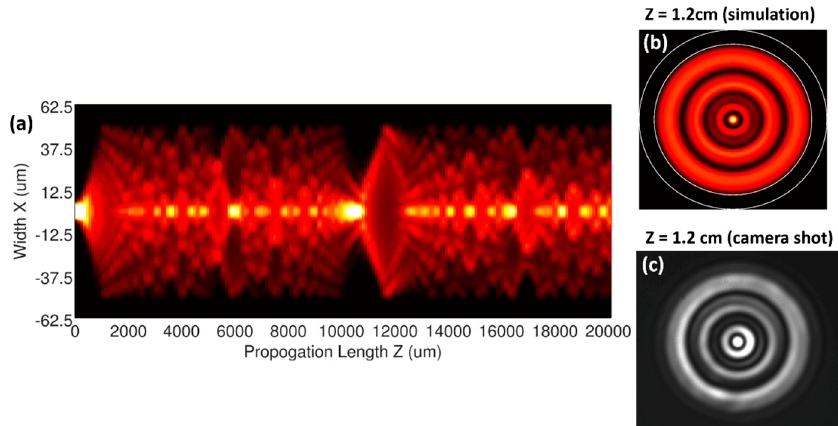
Figure 2. ( a ) Intermodal interference profile inside the MMF along the fiber axis. ( b ) Simulated light intensity distribution and ( c ) camera shot of the fiber MMI at 12,000 µm.